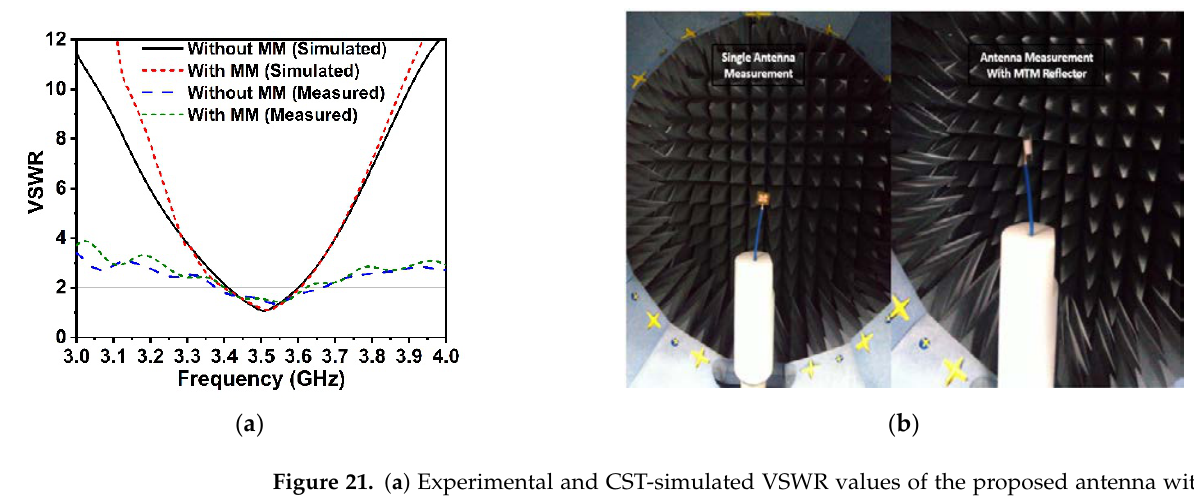
Figure 21. ( a ) Experimental and CST-simulated VSWR values of the proposed antenna with and without MM reflector. ( b ) Photographs demonstrate the antenna efficiency, radiation pattern, and gain measuring procedure at SATIMO near-field system lab, UKM.